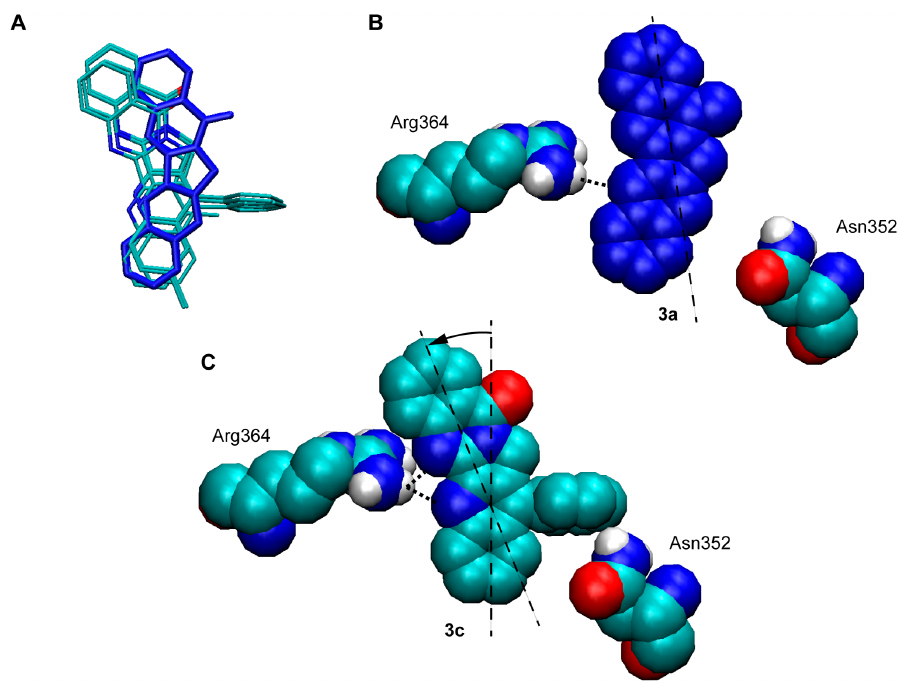
Figure 7. B-ring substitution improves hydrogen bonding to Arg364. A. Overlay of luotonin A ( 3a ) and compounds 3b – e at their binding sites, showing that the presence of the substituent at the C-14 position of ring B induces a rotation of the docking pose that leads to improved hydrogen bonding to Arg364 and hence to a better fit to the binding site. B. Docking of luotonin A showing the position of Asn352, which would interfere with any ring-B substituent. C. Docking of the B-phenyl substituted compound 3c, also showing the position of